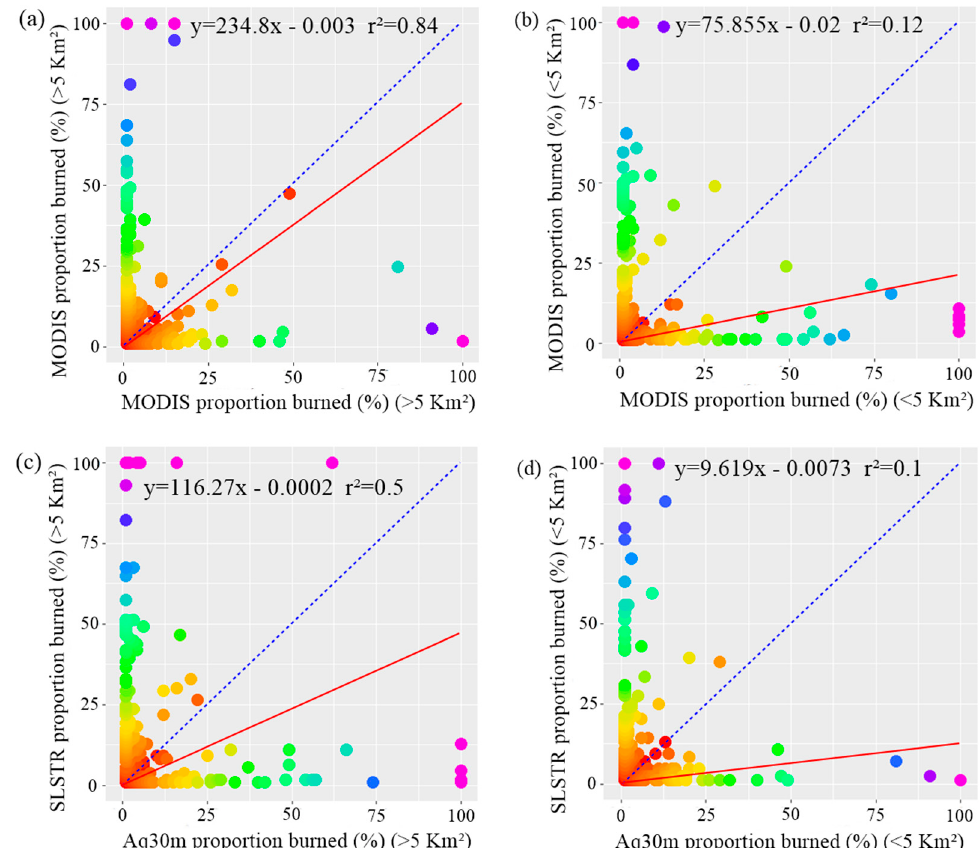
Figure 9. Linear regression by a 5 × 5 km proportion for small and large fires in the year 2021 for SLSTR and MODIS. ( a ) and ( c ) for small fires. ( b ) and ( d ) for large fires.